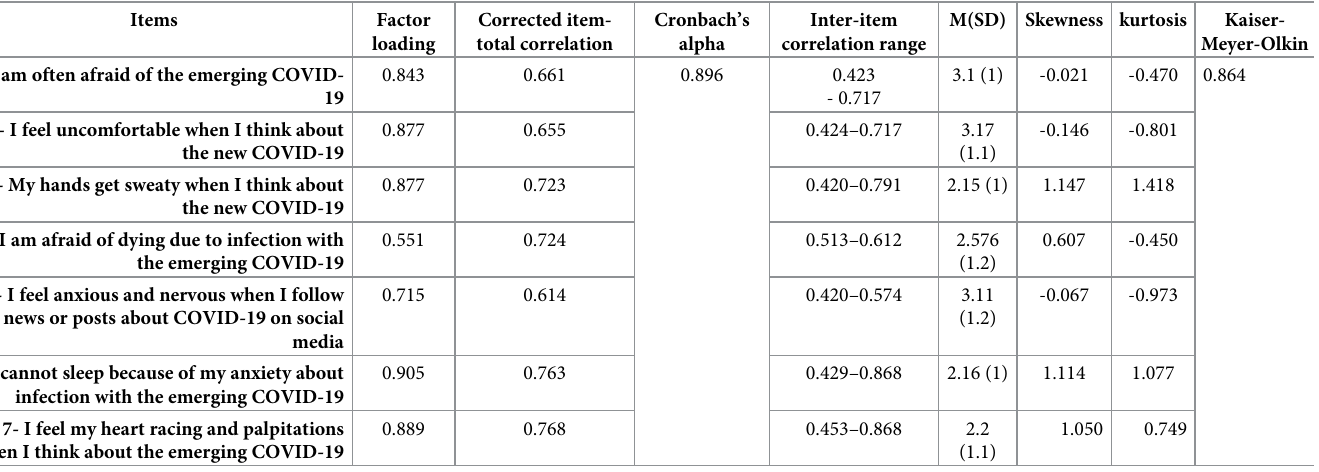
Table 3. FCV-19S construct validity analysis.